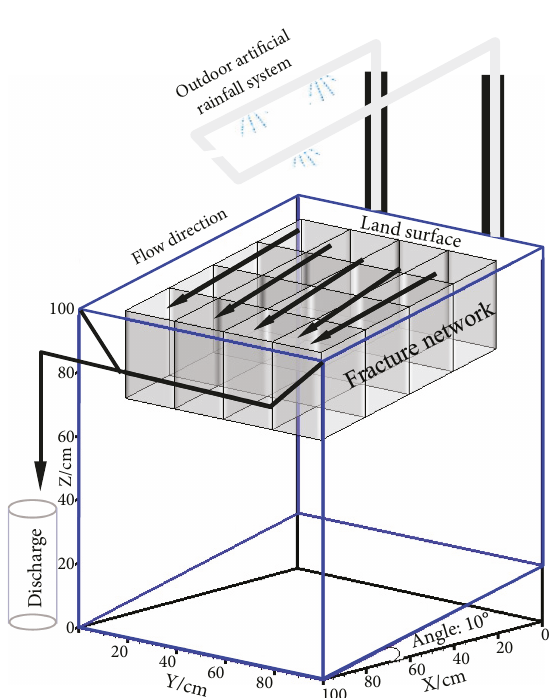
Figure 1: Sketch of experimental